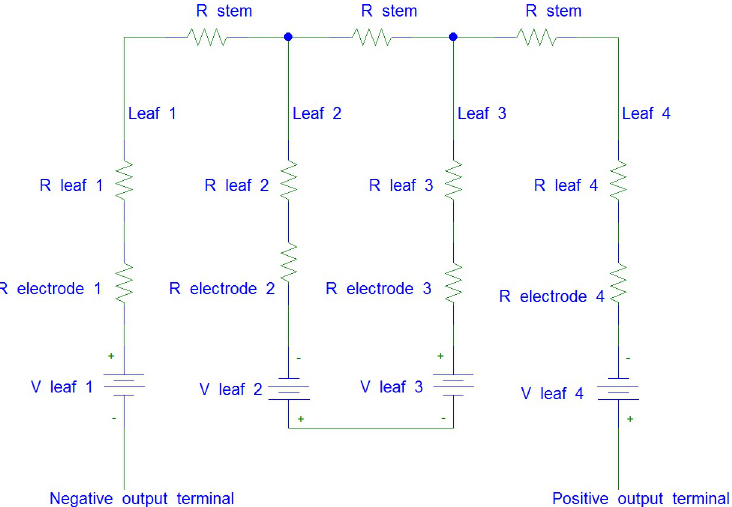
Fig 8. The equivalent circuit for series connection among leaves which passing through the stem of the Aloe Vera.